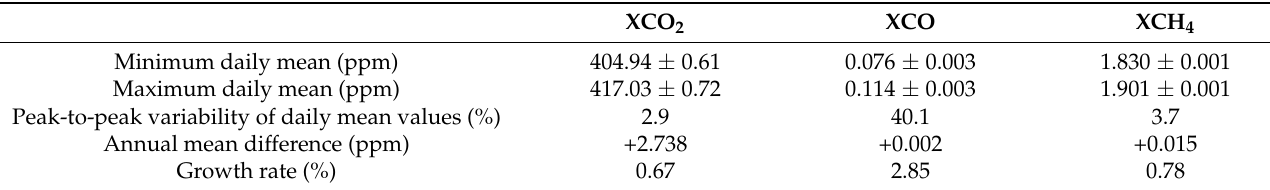
Table 1. Minimum and maximum values of the two-year timeseries of the daily means with their standard deviation, range of variability, yearly difference and growth rate are presented for XCO 2 , XCO and XCH 4 .